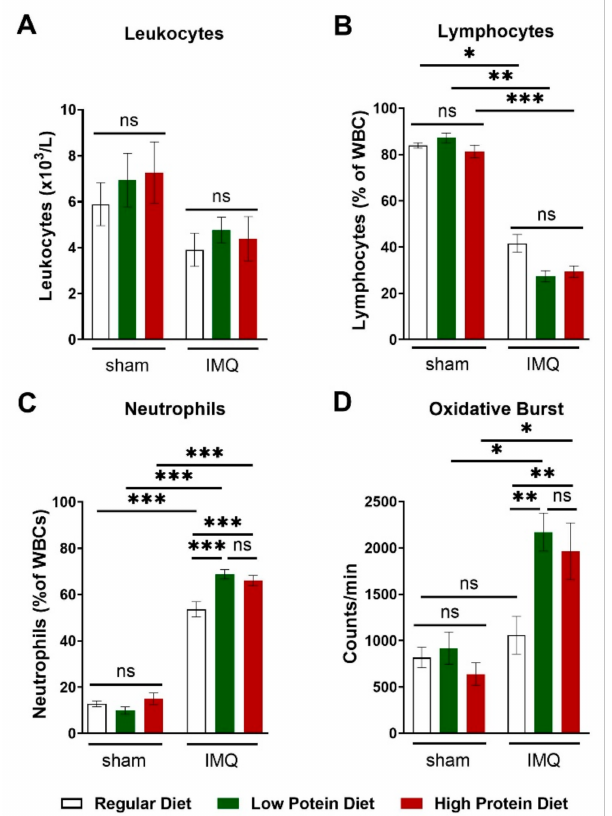
Figure 5. High and low protein diets increased numbers of circulating neutrophils and boosted the formation of reactive oxygen species in IMQ-induced psoriasis-like skin disease. ( A ) Absolute number of blood leucocyte counts in sham or IMQ-treated mice on a regular, low, or high protein diet ( n = 8–13; 2-way ANOVA). ( B ) Relative amount of blood lymphocytes and ( C ) neutrophils presented as % of white blood cells in sham or IMQ-treated mice on a regular, low, or high protein diet ( n = 8–13; 2-way ANOVA). ( D ) ROS/RNS measurement in whole blood (20 min of PDBu stimulation), repeated measurements of pooled samples; ( n = 5–12; 2-way ANOVA). Data are shown as mean ± SEM. *** p < 0.001; ** p < 0.01; * p <